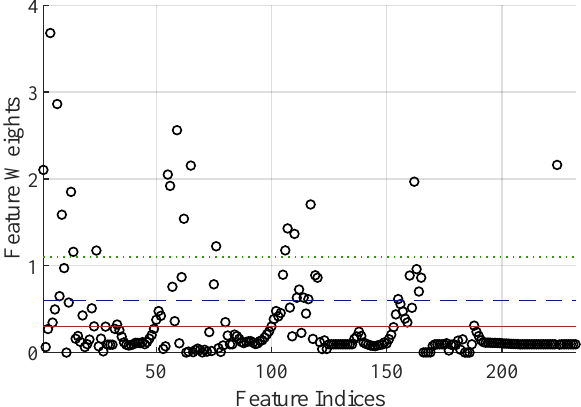
Figure 9. Plot of the neighborhood component feature selection.